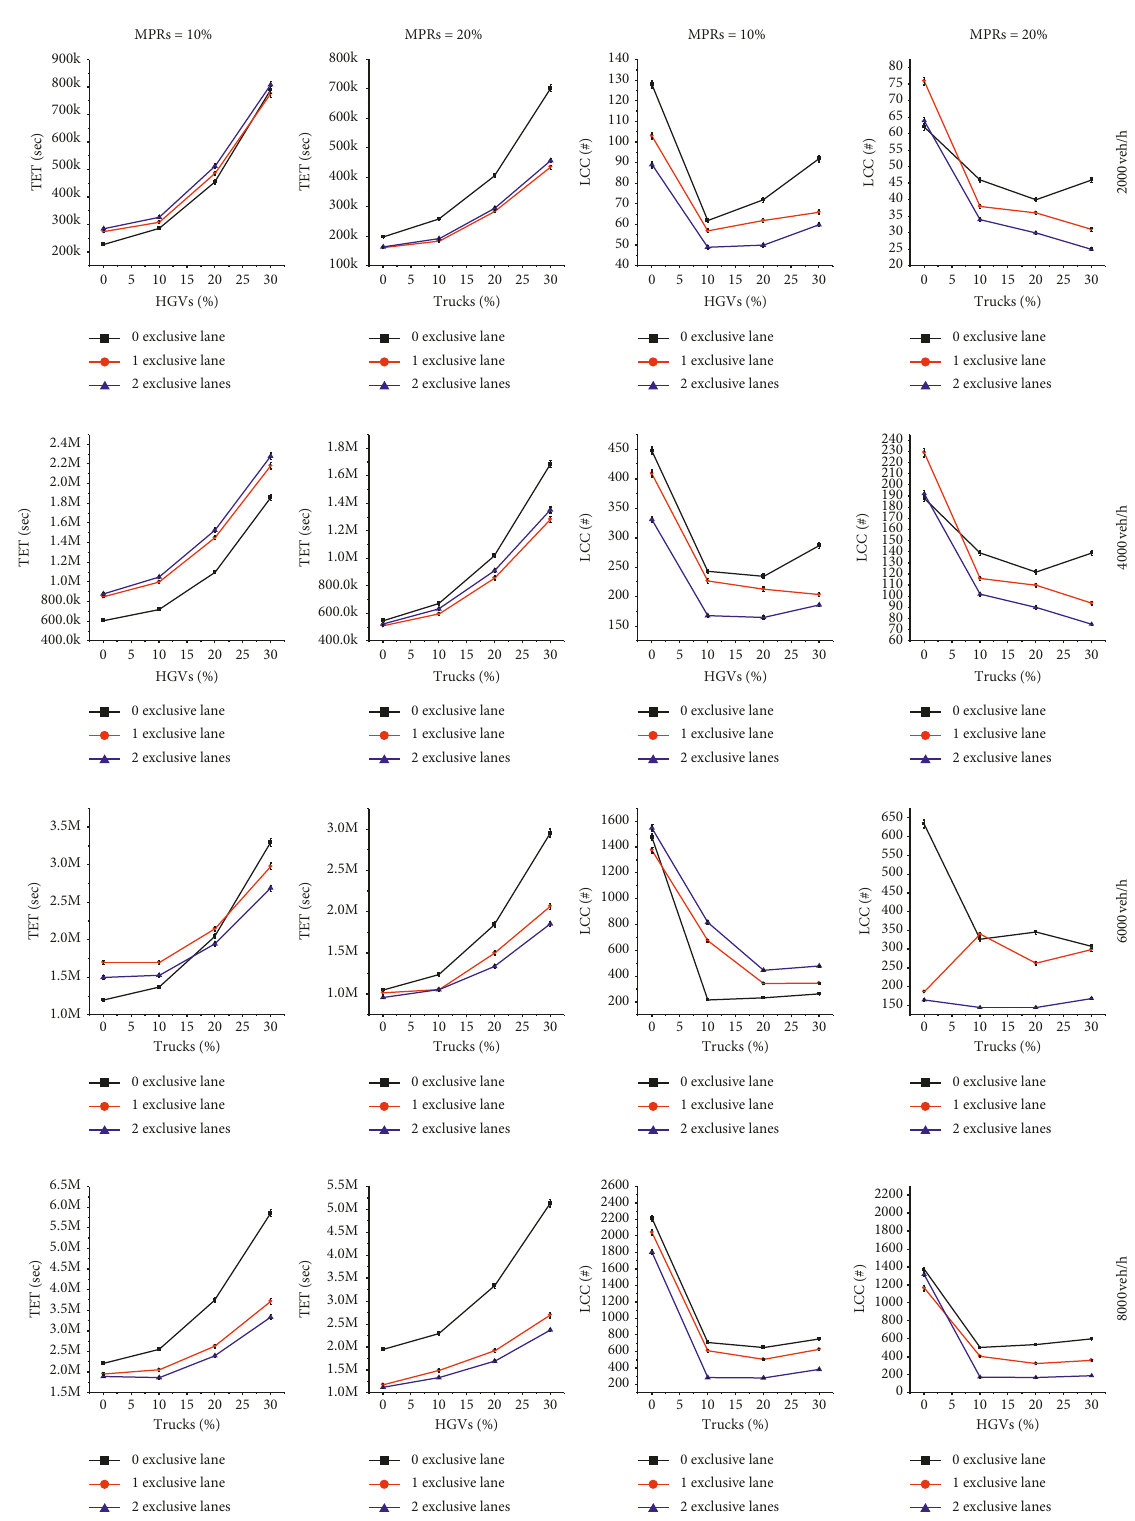
Figure 8: Comparison of safety impacts between MPRs � 10% and MPRs �